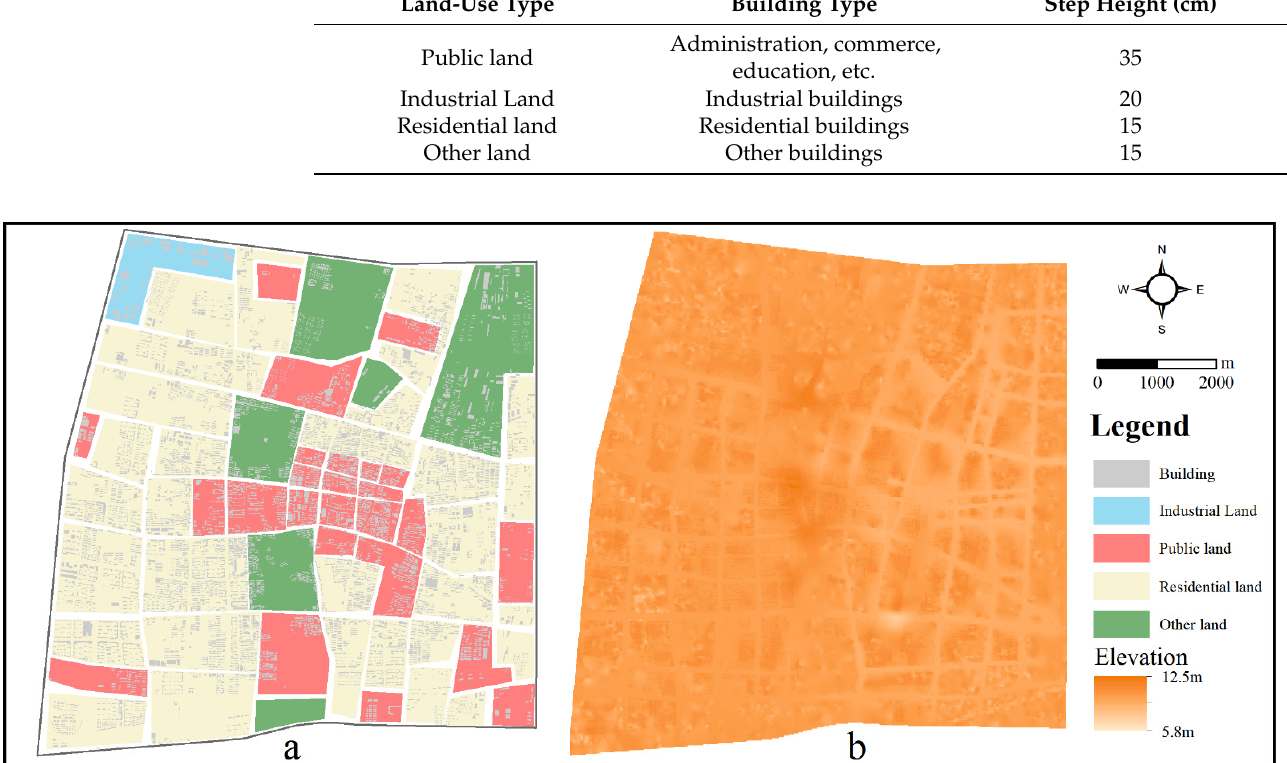
Table 1. Classification of building step heights.